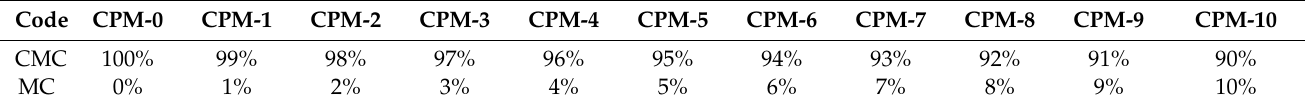
Table 1. Code and composition of